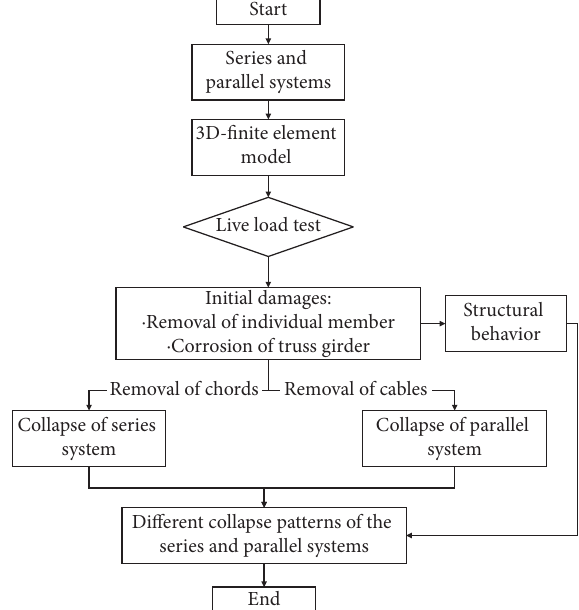
Figure 6: Flowchart of the collapse analysis of the cable-stayed bridge.